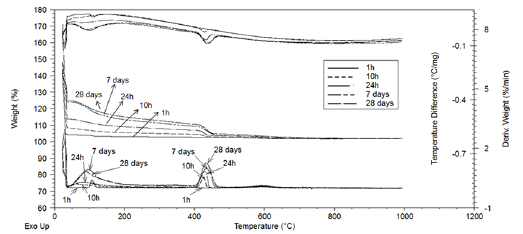
Figure 6. TG/DTG and DTA curves of reference.